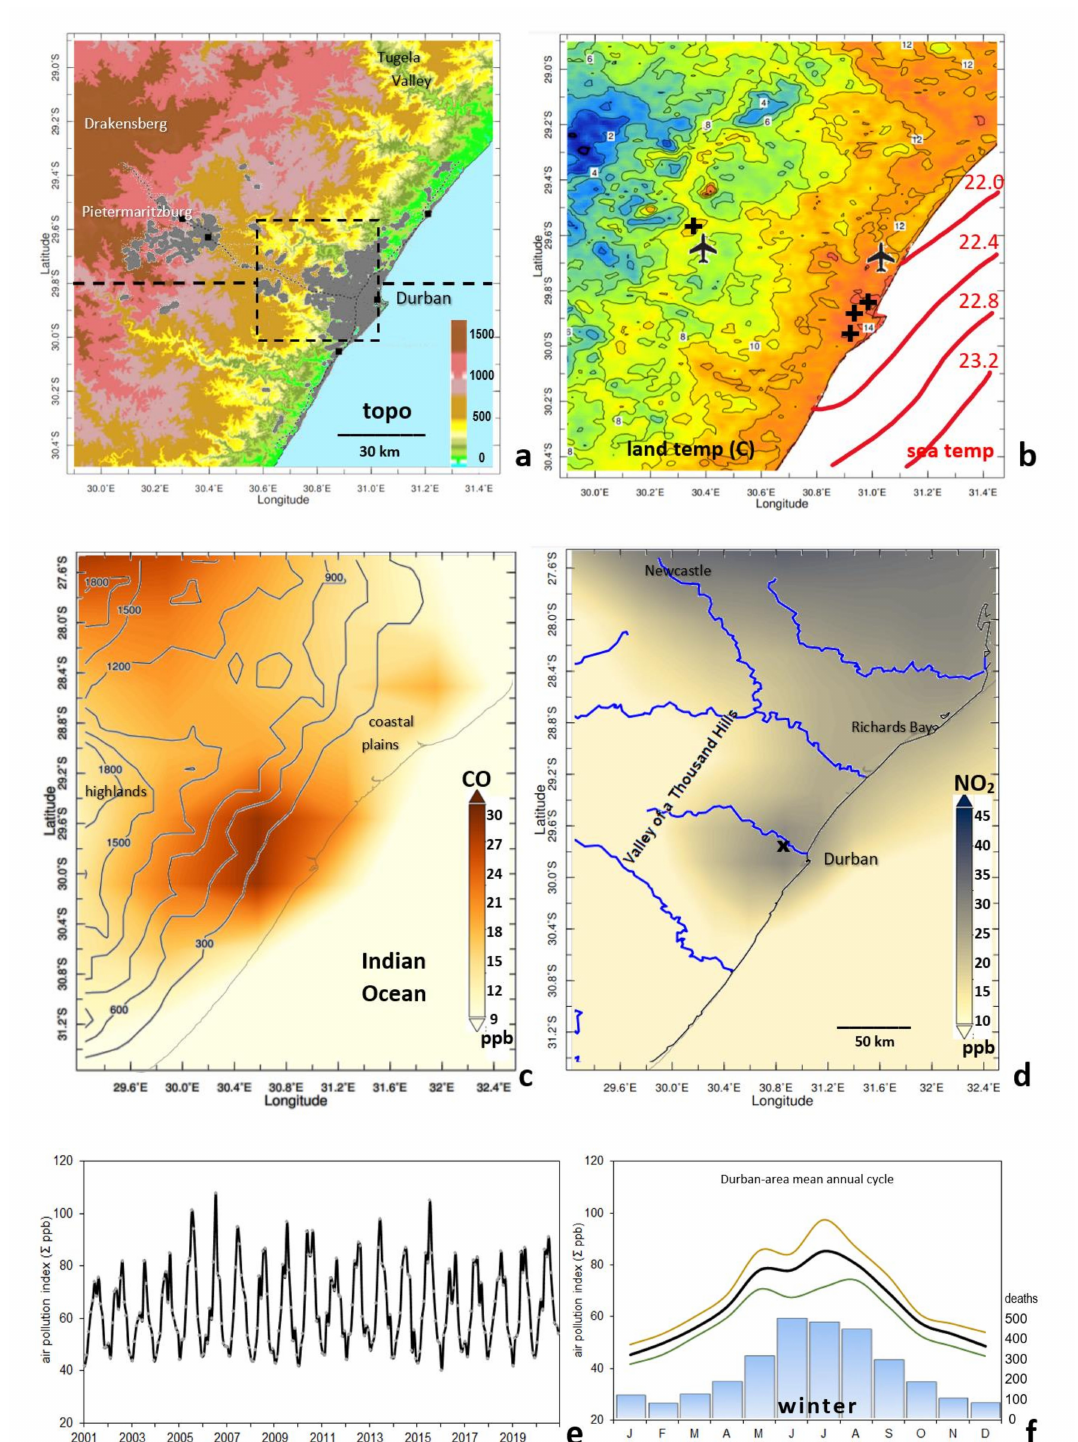
Figure 1. Maps of ( a ) elevation and urbanization (grey) and ( b ) satellite nocturnal land surface temperature and SST isotherms ( ◦ C) with airport icons and in-situ stations (+). Long-term mean surface maps of ( c ) MERRA2 CO, ( d ) OMI NO 2 concentration (ppb), with elevations, major rivers and local maximum (x). Temporal graphs of ( e ) monthly Durban-area surface API, and ( f ) its mean annual cycle and upper/lower terciles (summed concentration Σ ppb). “Durban-area” is the dashed box in ( a ), dashed line is the section; KZN mean respiratory mortality bar chart in ( f ) uses right axis